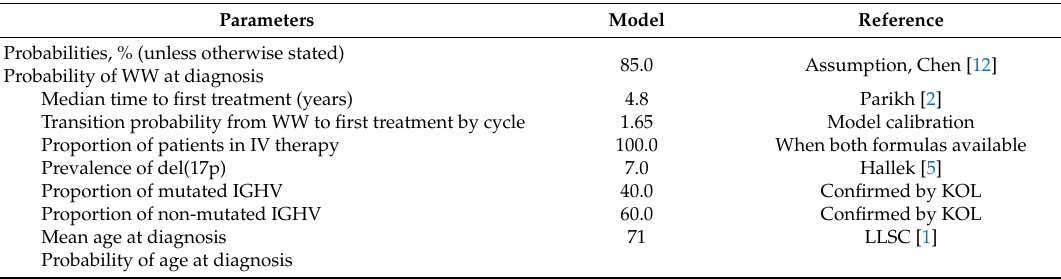
Table 1. Model and Cost a Parameters.